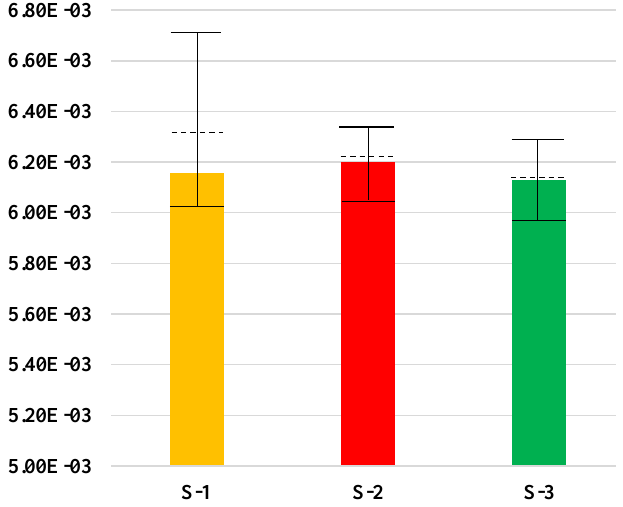
Figure 8. Single scored life cycle impacts with 95.0% confidence intervals calculated by Monte Carlo uncertainty analysis based on S1–3. Means, 2.5 to 97.5% confidence intervals are: S-1, 6.3140E − 03, 6.0029E − 3~6.6557E − 03; S-2, 6.2086E − 03, 6.0506E − 03~6.3681E − 03; S-3, 6.1342E − 03, and 5.9790E − 03~6.2883E − 03. (See Tables S2 and S3 for